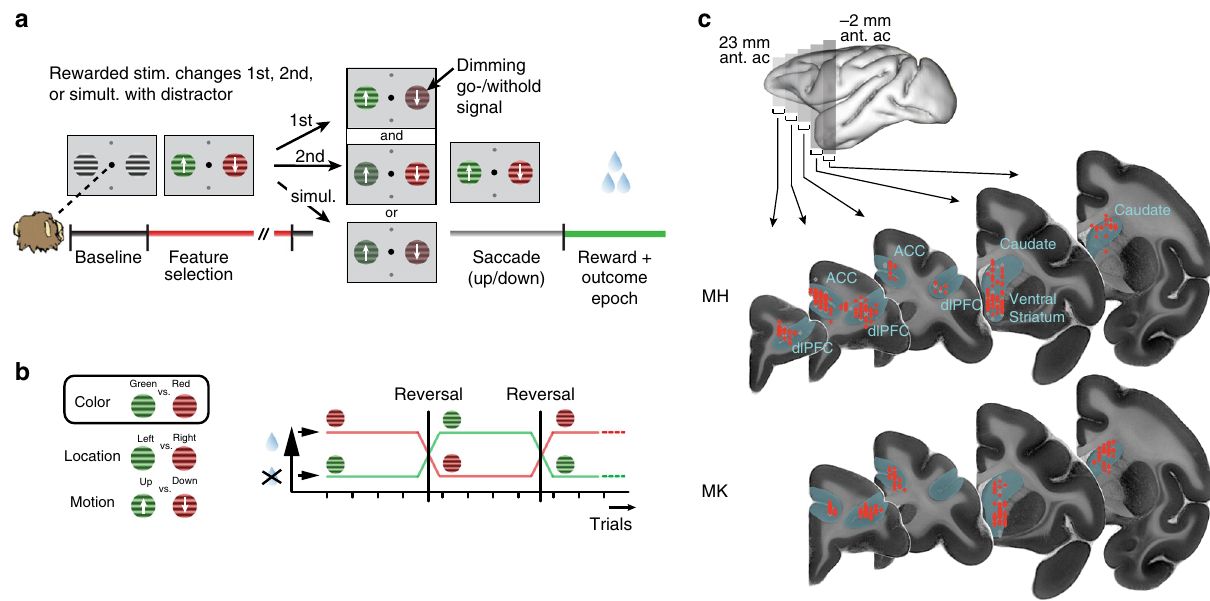
Fig. 1 Feature-based reversal learning task and anatomical recording locations. a Animals are presented with two black/white stimulus gratings to the left and right of a central fi xation point. The stimulus gratings then become colored and start moving in opposite directions. Dimming of the stimuli served as Choice/Go signal. At the time of the dimming of the target stimulus the animals had to indicate the motion direction of the target stimulus by making a corresponding up or downward saccade in order to receive a liquid reward. Dimming of the target stimulus occurred either before, after or at the same time as the dimming of the distractor stimulus. b Left: Three features characterize each stimulus — color, location, and motion direction. Only the color feature is directly linked to reward outcome. The task is a deterministic reversal learning task, whereby only one color at a time is rewarded. Right: This reward contingency switches repeatedly and unannounced in a block-design fashion. c Illustration of recording locations relative to stereotaxic zero for monkey H (top) and monkey K (bottom). Neuron locations are collapsed across 5 mm coronal slices indicated by the gray bars on the brain on top. Red circles represent neurons that encoded a feature-speci fi c prediction error, gray circles represent neurons that did not. Ant. ac. refers to anterior of anterior commissure. Imaging data provided by the Duke Center for in vivo microscopy